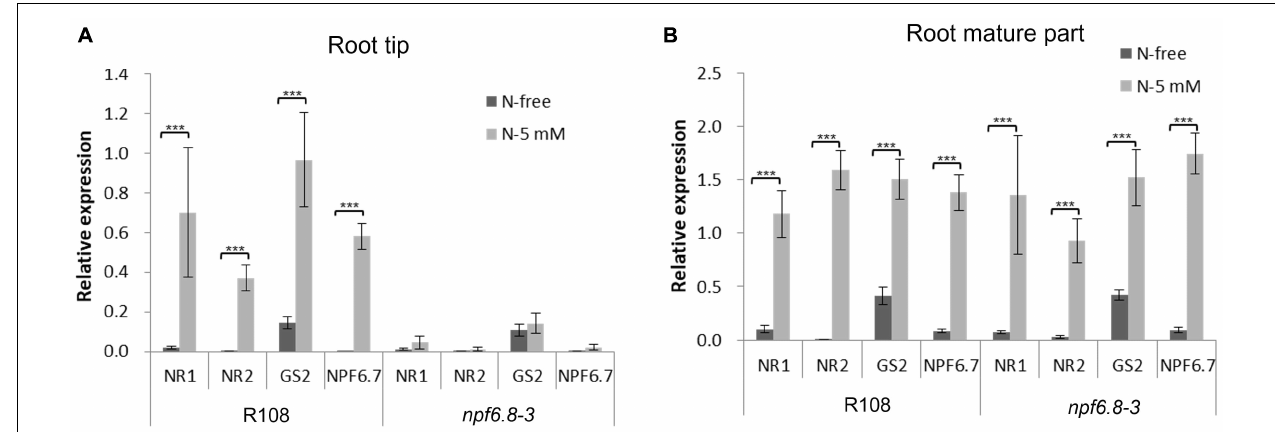
FIGURE 4 | Relative expression of sentinel nitrate-responsive genes in the primary root tip and root mature part of R108 and npf6.8-3 . RNAs were extracted from R108 or npf6.8-3 root tip and root mature part of 10 days old seedlings grown in MS without nitrate (N-free) or with 5 mM nitrate (N-5 mM). RT-qPCR experiments were performed with root tip RNAs (A) or root mature part RNAs (B) using MtRPB1 and MtMsc27 as reference genes. NR1 , nitrate reductase 1; NR2 , nitrate reductase 2; GS2 , glutamine synthetase; NPF6.7 , NRT1/PTR Family 6.7. The statistical test used is an ANOVA (p < 0.001).